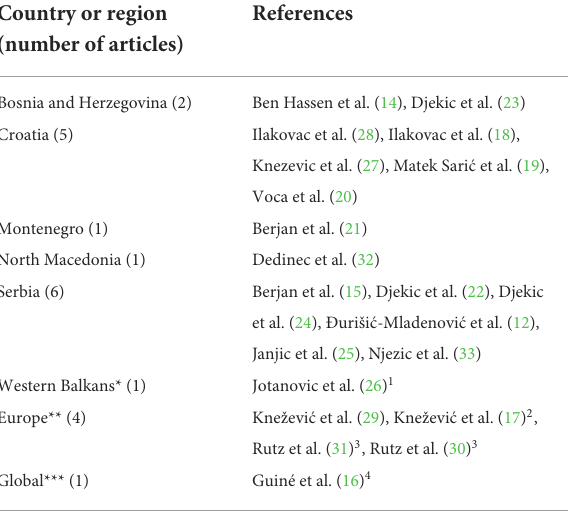
TABLE 2 Geography of the research on FLW in the Western Balkan countries. Country or